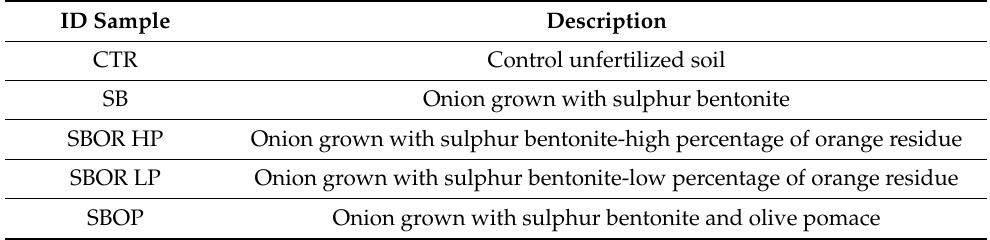
Table 3. Experimental